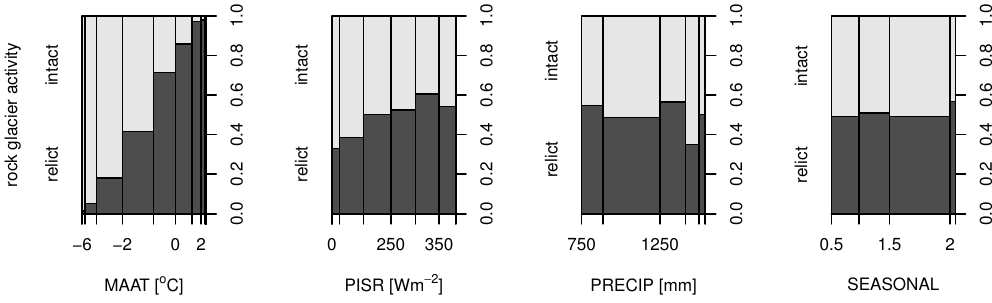
Fig. 2. Frequencies of intact as opposed to relict rock glaciers conditional on potential explanatory variables. Bar widths in these spinograms are proportional to the empirical frequency of the given interval of values of explanatory variable. The figure does not account for random inventory